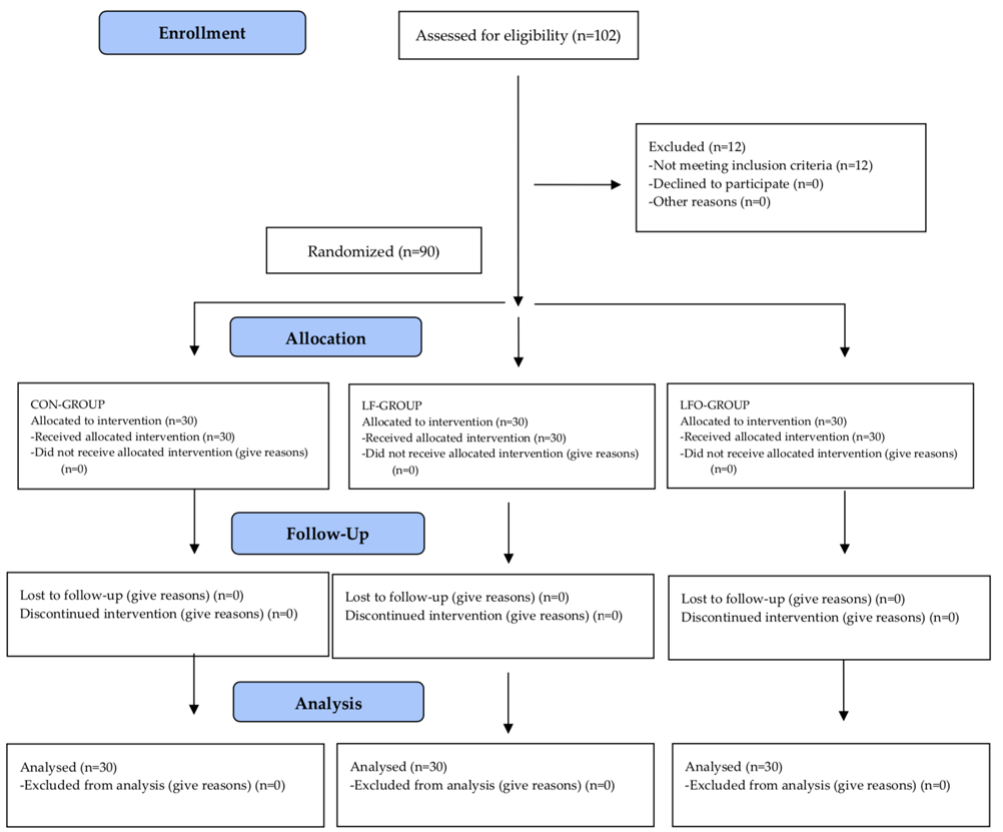
Figure 1. CONSORT flow